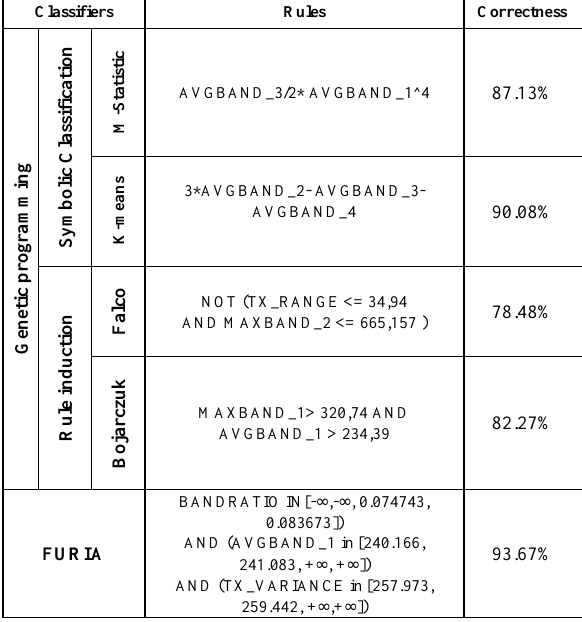
Table 3. Results of extraction of built-up objects As it was expected different classifiers have used spectral, bandratio and texture attributes to separate the built-up areas